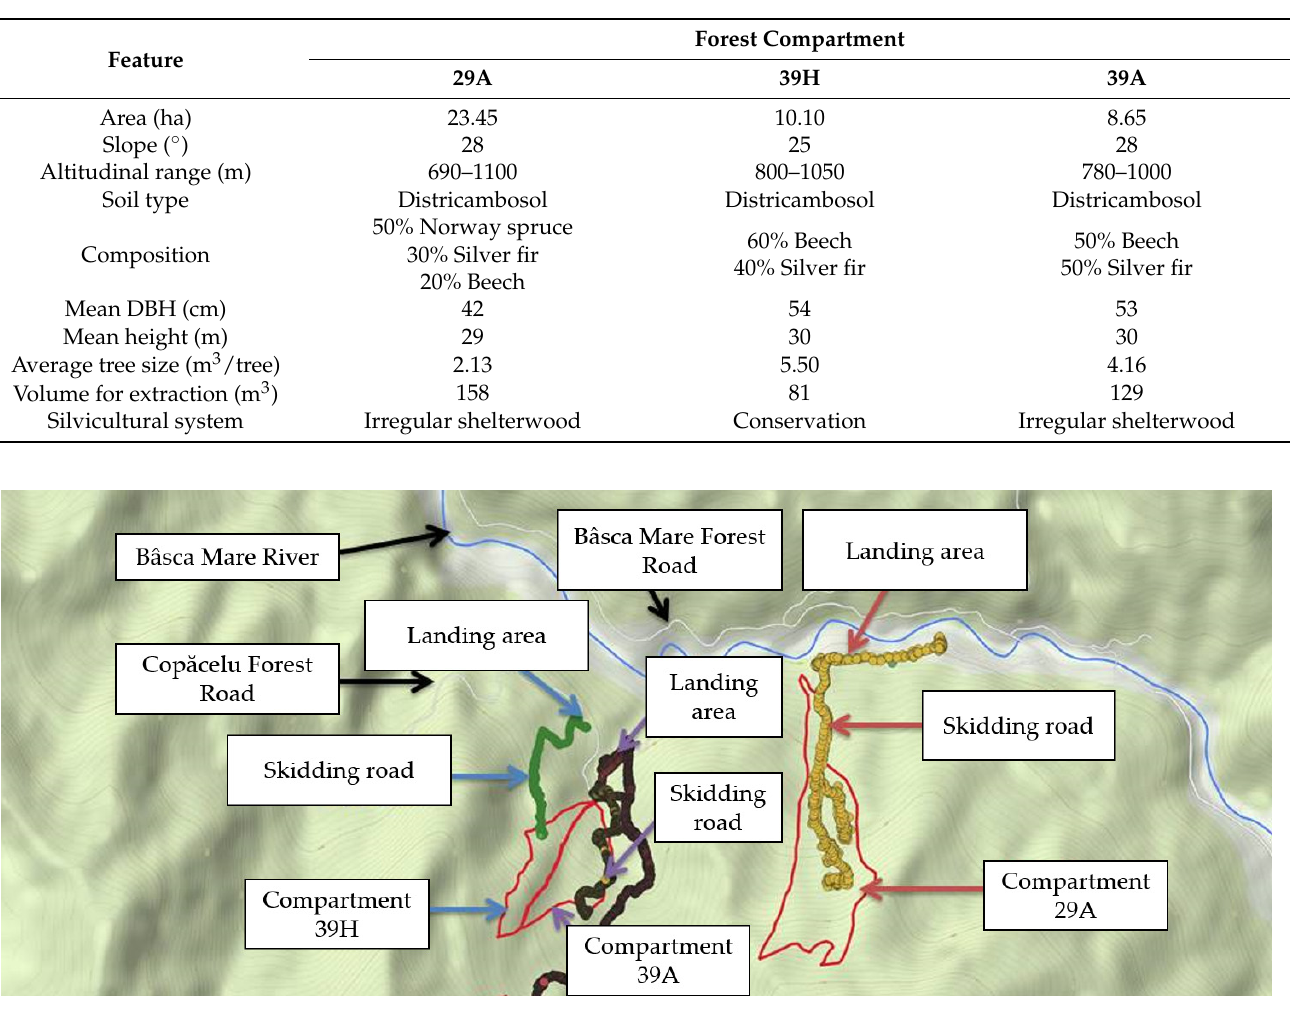
Figure 1. Location of the forest compartments, skidding roads, and landing areas. Source: image developed in QGis based on field-collected GPS locations and freely available topography layers available for download in QGis.